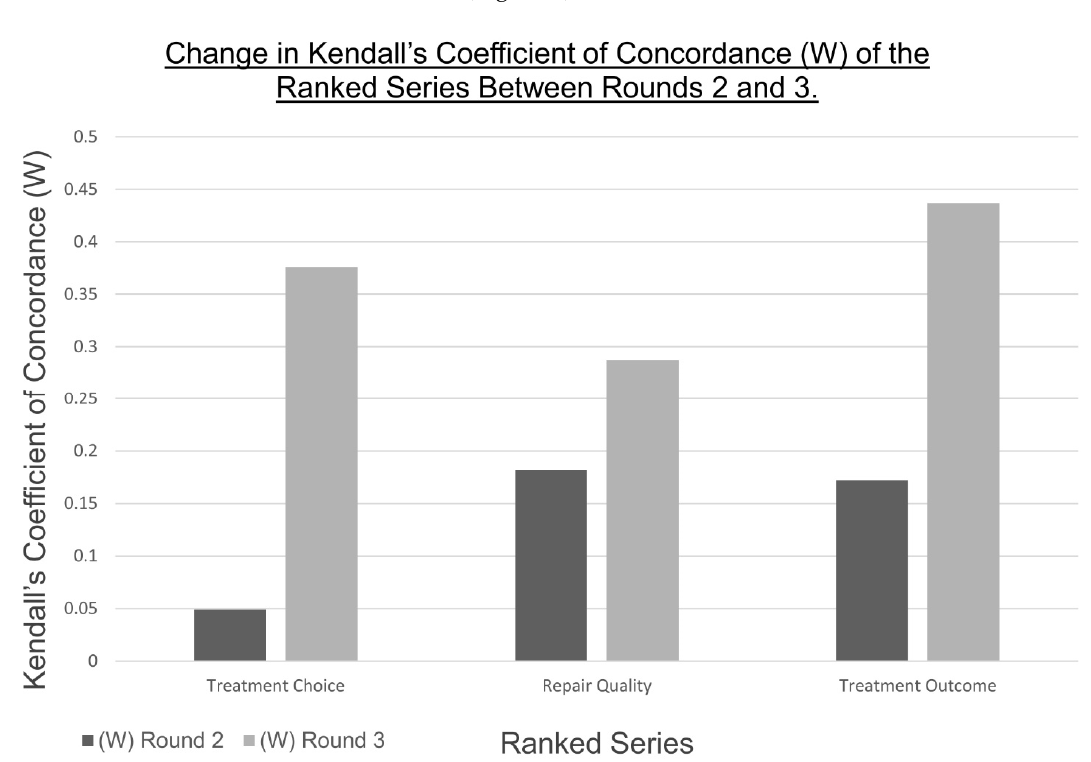
Figure 7. Change in Kendall’s coefficient of concordance (W) between rounds 2 and 3 for the ranked series that did not reach consensus in this Delphi study.